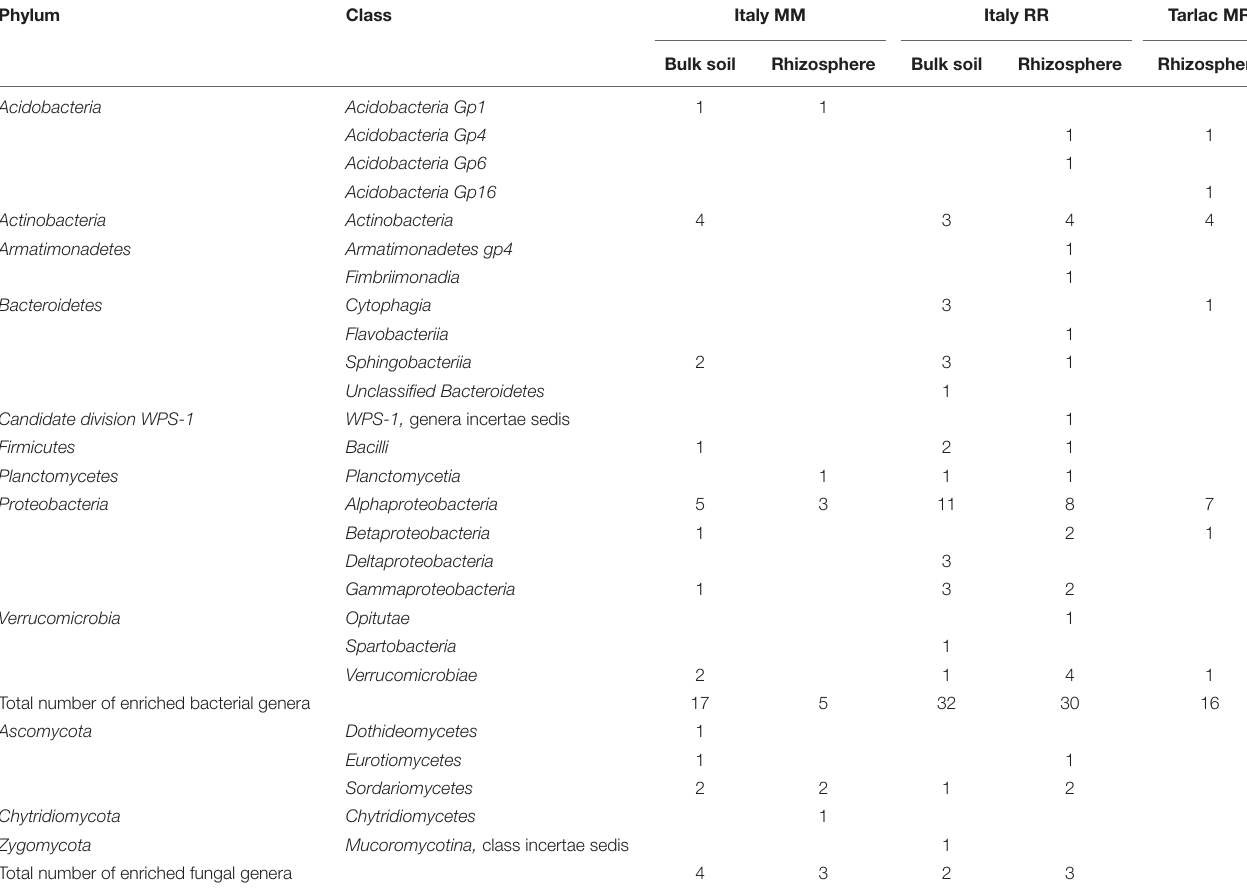
TABLE 2 | Number of genera significantly enriched in soils with straw application.